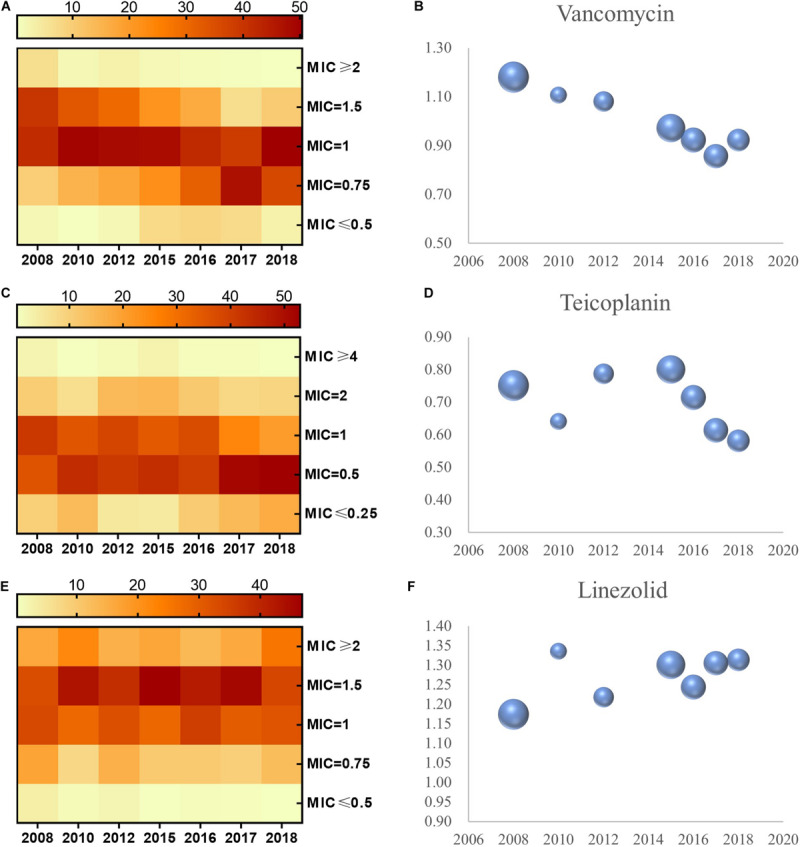
MIC distribution and the geometric mean of MIC values for vancomycin, teicoplanin, and linezolid in S. aureus, 2008–2018. MIC distribution of S. aureus to vancomycin, teicoplanin, and linezolid (A,C,E). Geometric mean MIC determined by E-test method over the study period (B,D,F). The bubble size represents sample size of isolates.